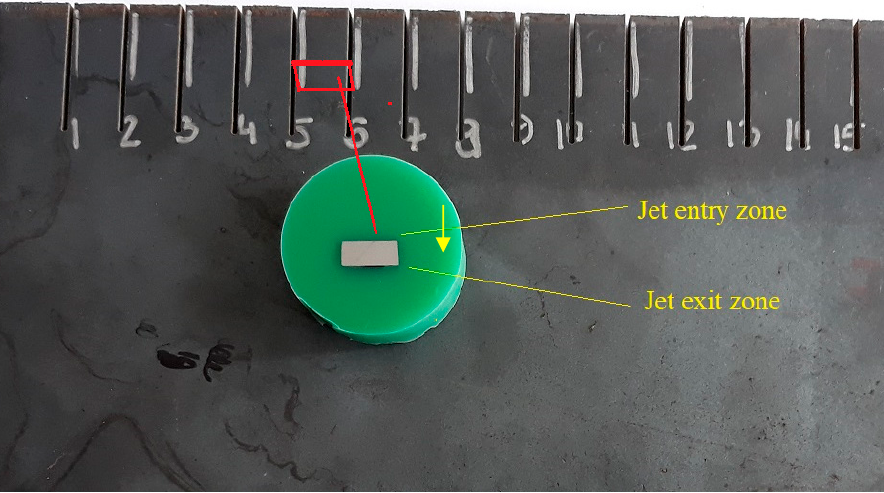
Figure 2. A specimen prepared for the analysis compared with the original steel plate. A S235JR steel plate with a thickness of 4 mm was used to prepare the specimens (Figure 2). The material analyzed prior to cutting had a characteristic structure with visible plastic deformation being a result of hot rolling. The ferrite and pearlite grains were distributed in lines parallel to the rolling direction. It is commonly known that the greatest plastic deformations occur in places where the material is in contact with rollers. Grains in the surface layer are much smaller than those lying at greater depths (Figure 3). The presence of fine grains in the surface layer confirms that the plastic deformation and strain hardening, being a result of direct contact with the rollers, are greater than those further from the surface.